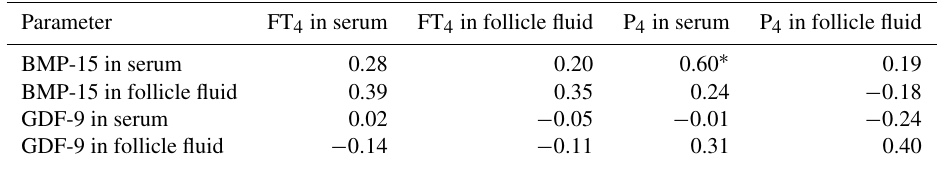
Table 3. Correlation coefficients ( r ) between FT 4 and P 4 concentrations and the concentration of the transforming growth factors (BMP-15 and GDF-9) in the preovulatory follicle fluid and serum of non-cysts-bearing sows ( n =